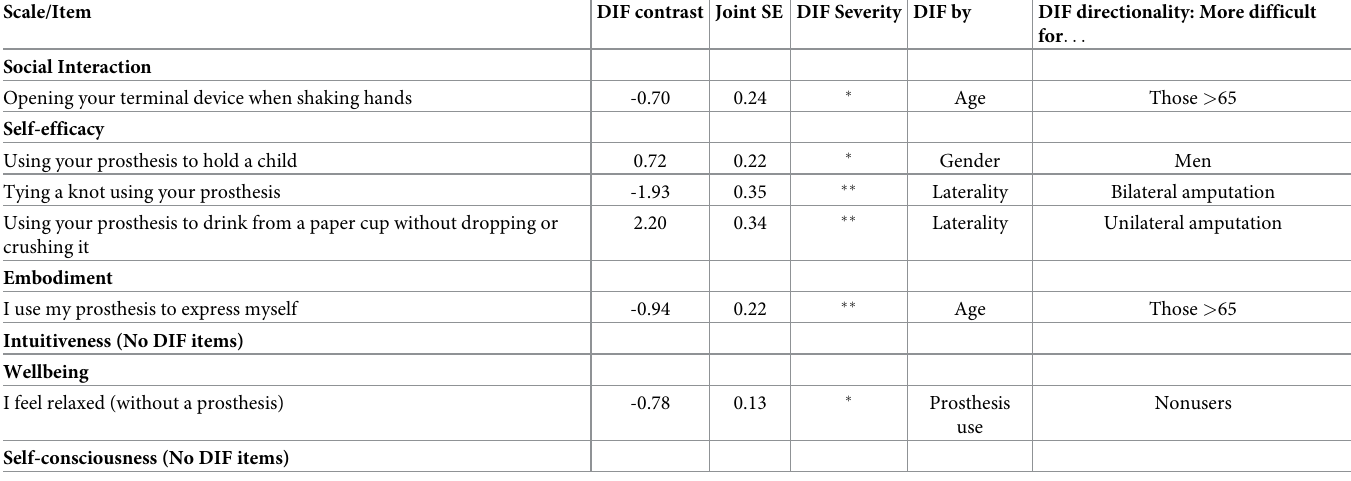
Table 4. Differential Item Functioning (DIF)